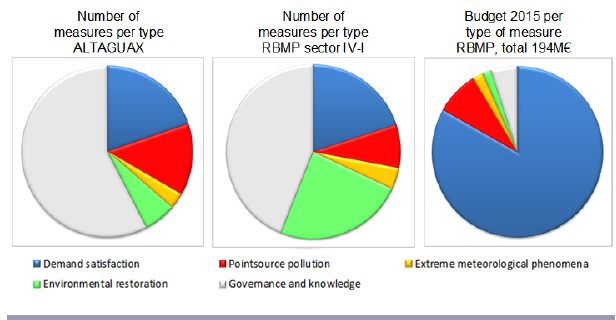
Fig. 5. Distribution of (a) measures mentioned in the participatory workshops vs. (b) the official river basin management plan (RBMP, also referred to as hydrological plan, HP) and (c) distribution of total budget of 194 M€ for 2015 in sector IV-I per type of measure as recorded in the final hydrological